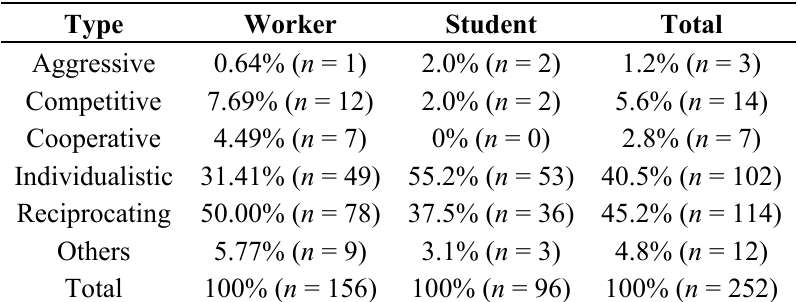
Table A12. Distribution of types in the two